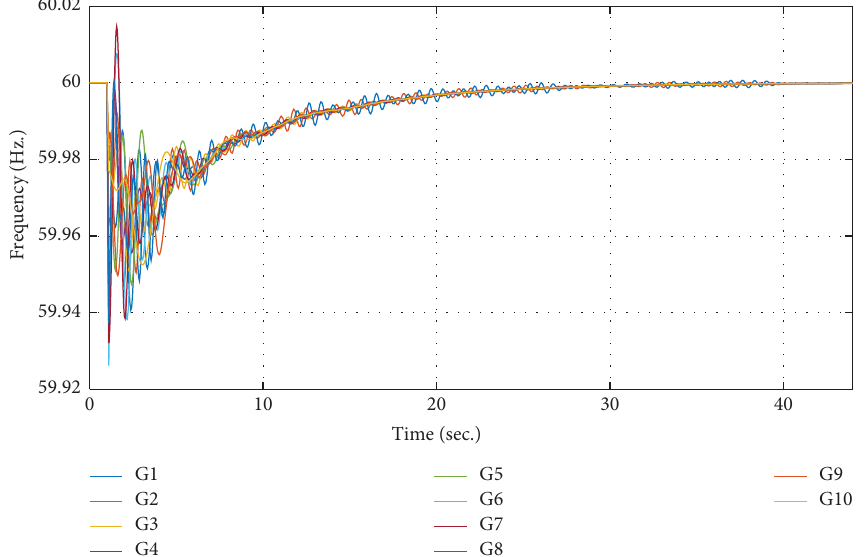
Figure 9: Time-domain simulation of IEEE 39-bus system for the proposed method.